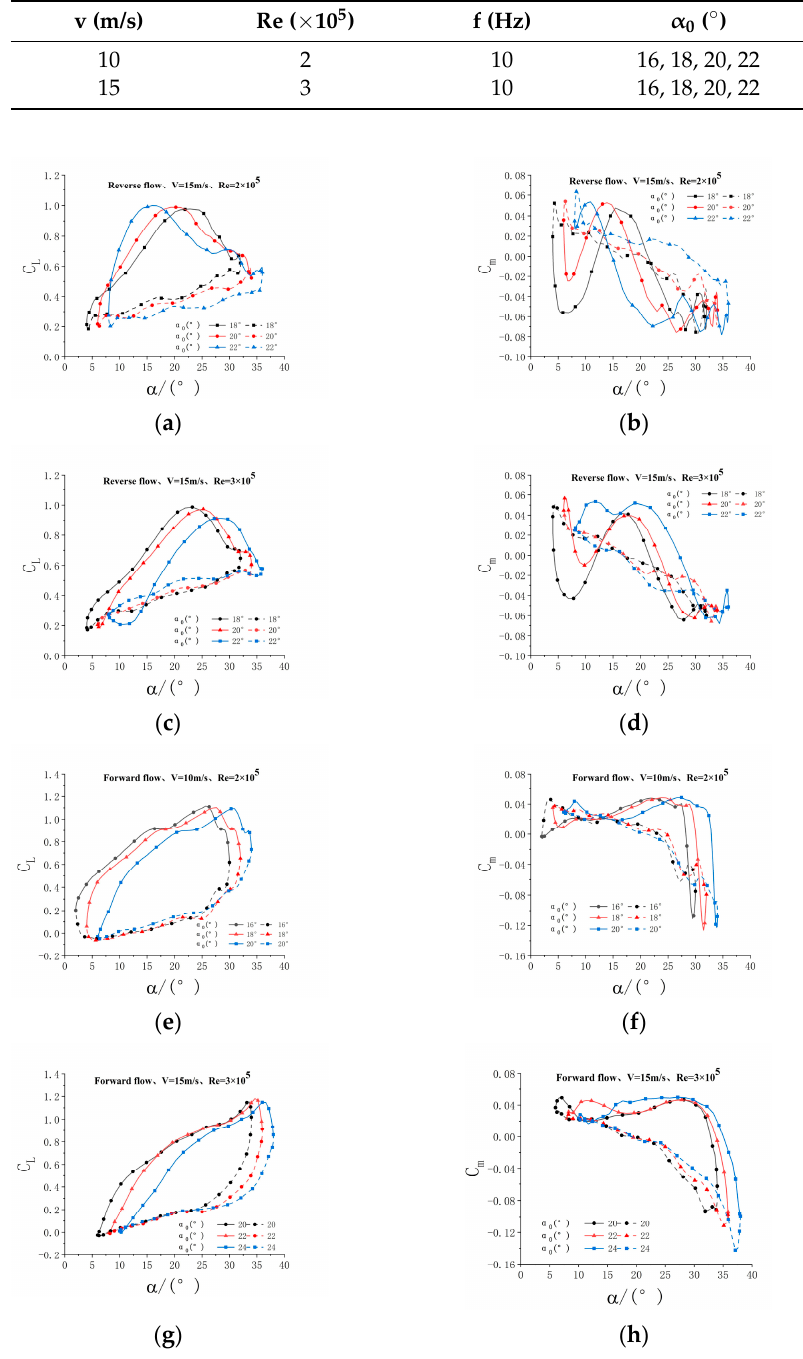
Figure 15. Effect of the mean angle of pitch at different Reynolds numbers. ( a ) Re = 2 × 10 5 , C L , ( b